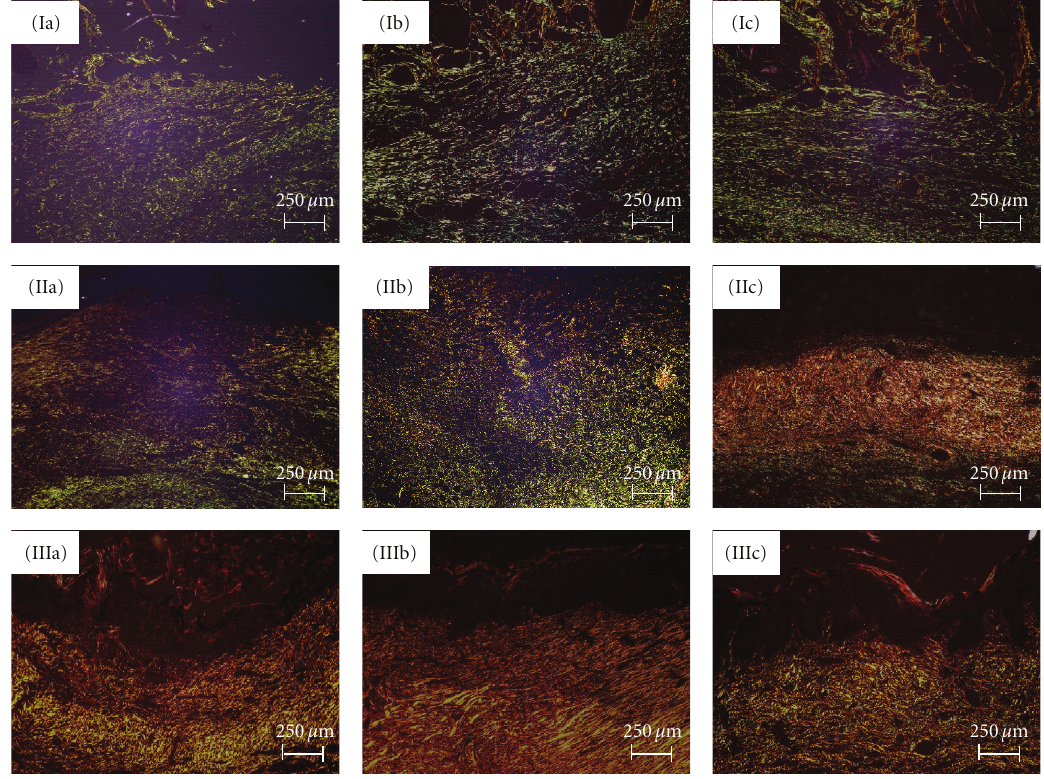
Figure 4: Histological sections stained in Sirius red, analyzed under polarized light. Seven days: thin delicate reticularlyarranged type-III collagen fibrils seen in COL (Ia), PHO (Ib), and UAL (Ic). Fourteen days: predominance of type-III collagen fibrils is maintained in COL (IIa), and PHO (IIb), whereas in UAL (IIc) there is predominance of type-I collagen fibers. Twenty-one days: intense deposition of type I collagen fibers seen in COL (IIIa) and PHO (IIIb) whereas in UAL, a mix of wavy and highly interlaced type I and type III collagen fibers is